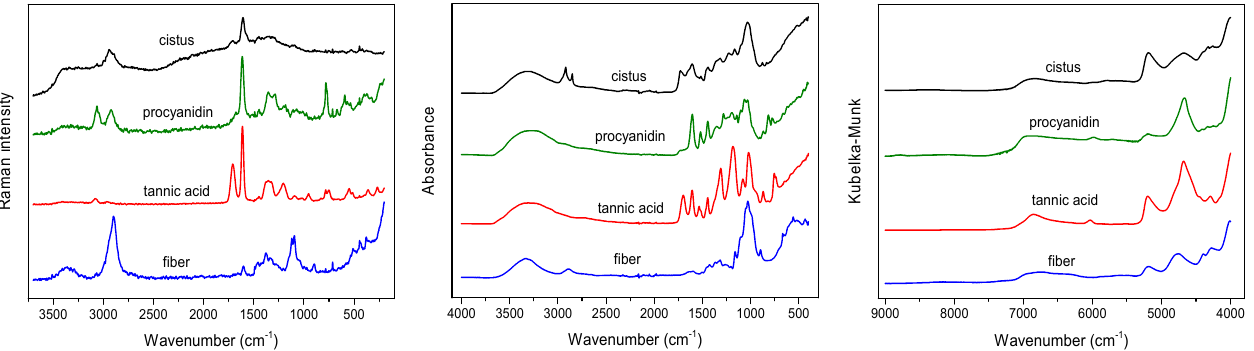
Figure 1. Raman ( left ), ATR ( middle ) and NIR ( right ) spectra of dried C. incanus material and selected compounds .